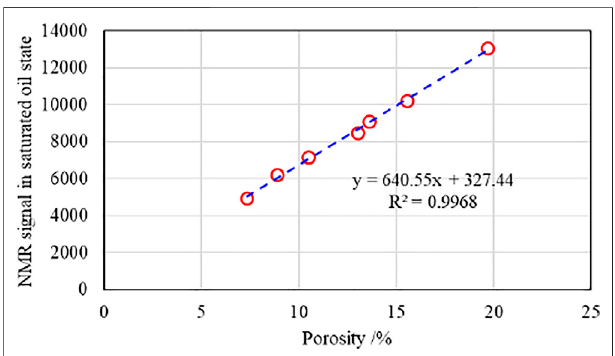
FIGURE 7 | Relationship between the NMR signal and gas porosity at the saturated oil